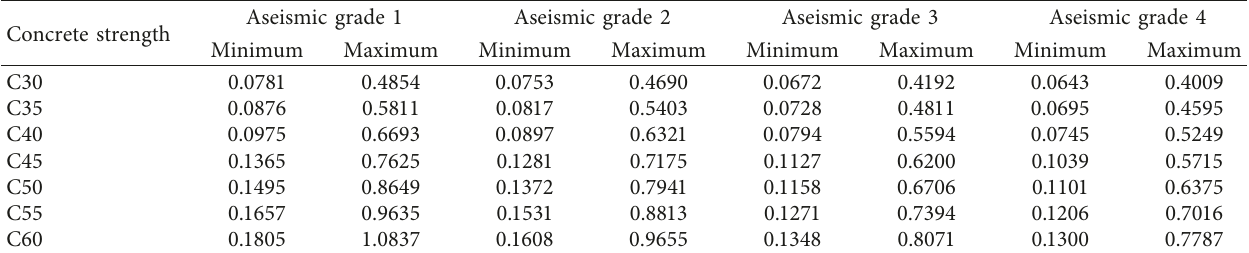
Table 1: Range of beam-to-column linear stiffness ratio for different aseismic grades.